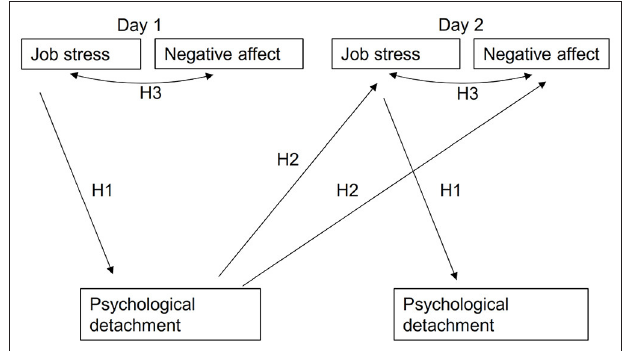
FIGURE 1 | The model with the hypothesized associations between